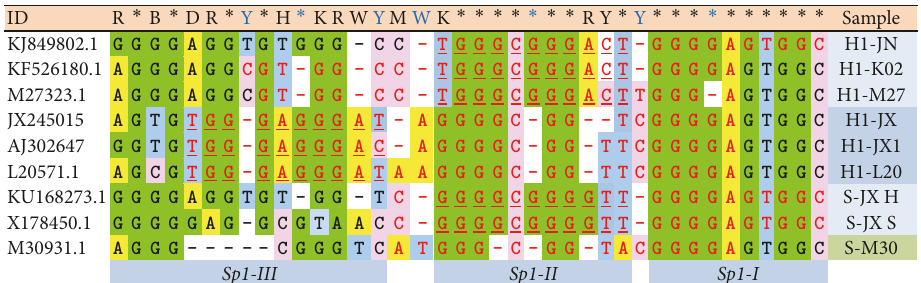
Figure 4: Sequence alignment of LTR regions containing the sequence listed in Figure 1. Possible gaps are marked with blue letters or symbols. The red letters represent the sequences used in this study. Sp1 consensus sequences are